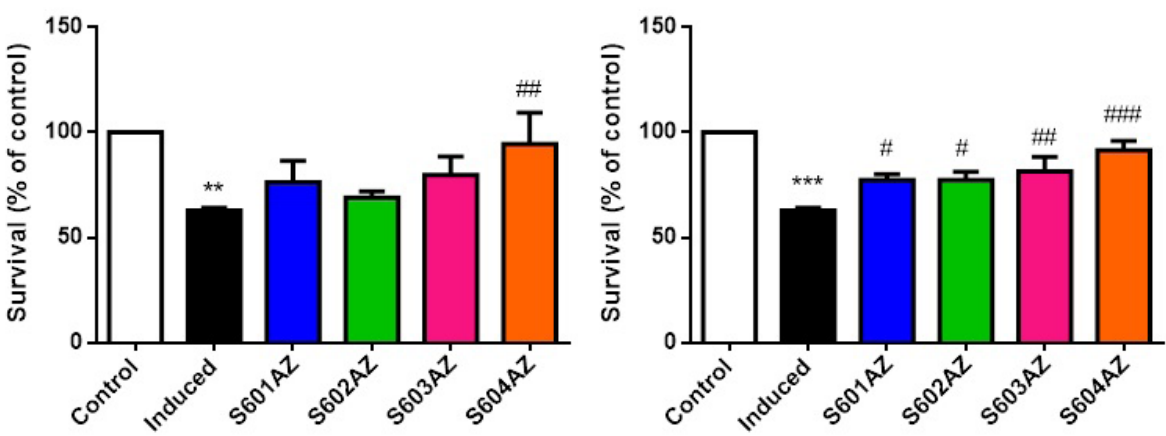
Figure 3. The effect of β-aryl-chalcogenium azide compounds at concentration of 1µM (a) and 10µM (b) against the damage induced by hydrogen peroxide (H experiments. ** p<0.01; *** p<0.001 as compared to control group, # p<0.05; ## p<0.01; ### p<0.001 as compared to induced